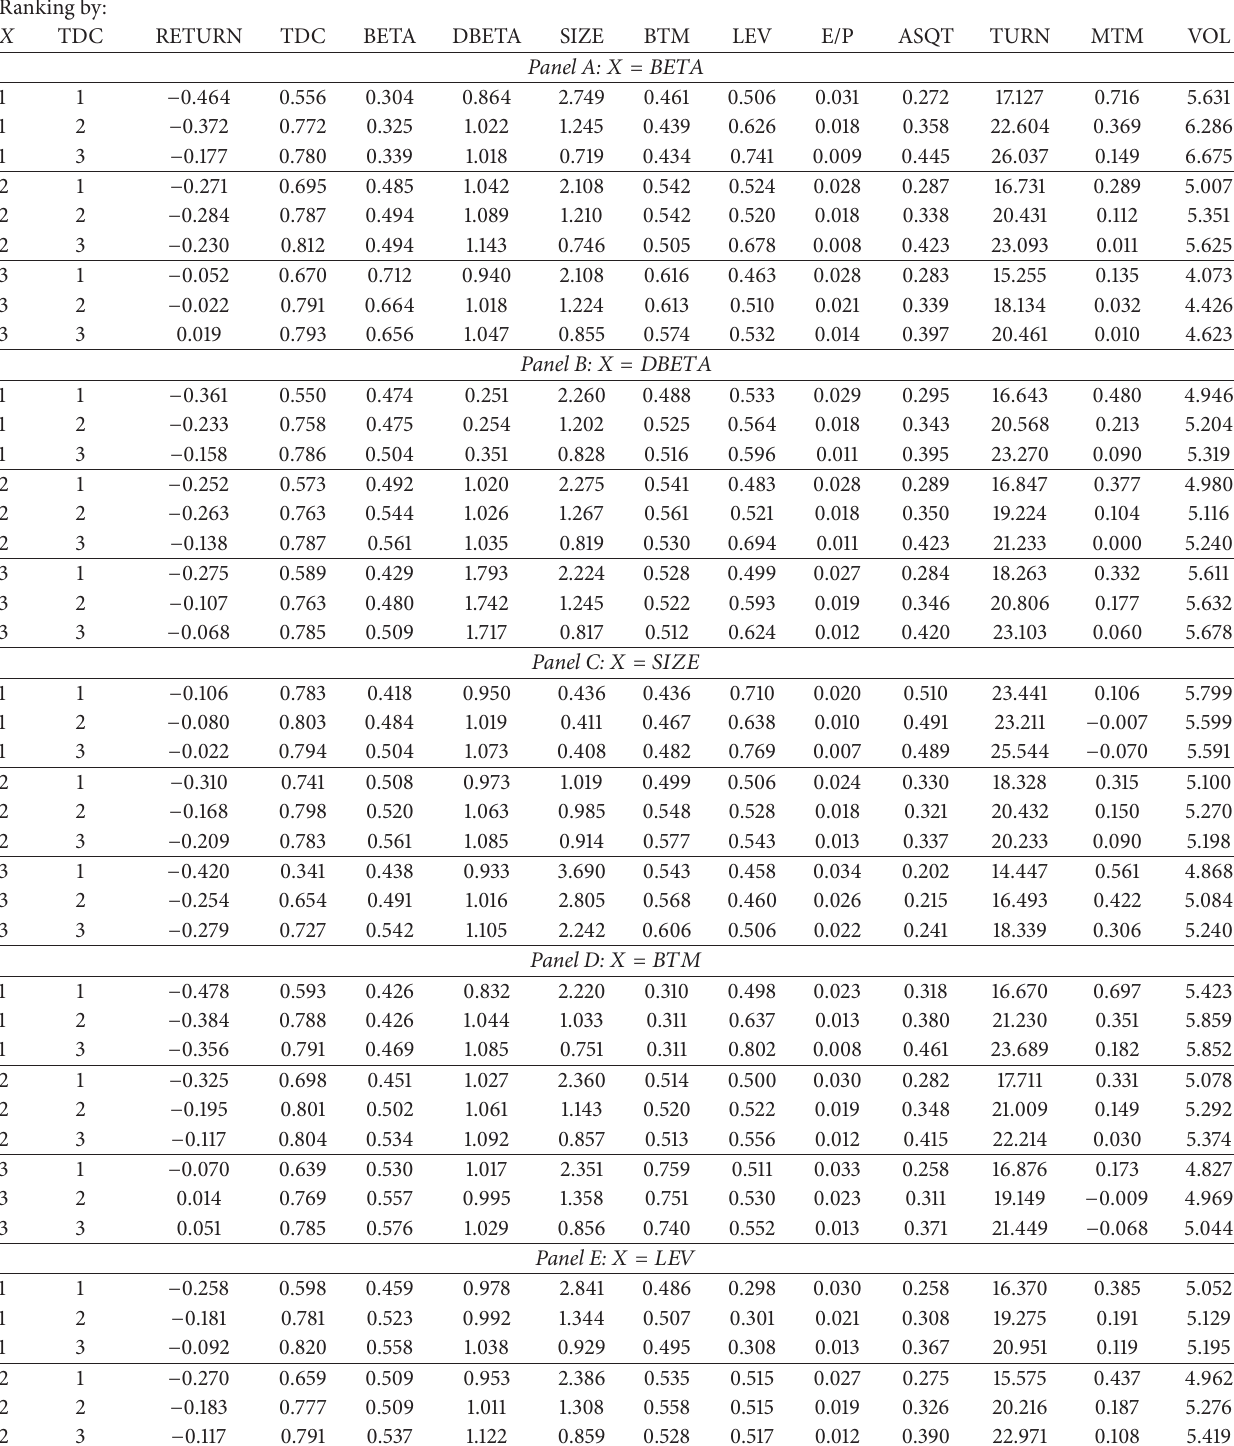
Table4:Returns,taildependence,andotherfactors.Portfoliosareformedmonthly.Ineachmonth,thestocksareclassifiedintothreequintiles based on the preceding month’s value of a risk factor, and then each quintile is subdivided into three portfolios according to preranking TDCs. Thefull-periodportfolio taildependence coefficients and thetime-seriesaverages ofother characteristics arepresented in thistable. RETURN here is the average of postranking monthly portfolios returns, and all other variables are defined as in Table 2. From 1 to 3, the corresponding variables are